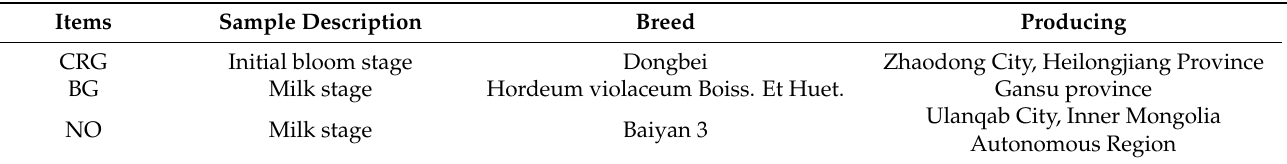
Table 1. Three forages (CRG, BG, and NO) information selected for the current study. Items Sample Description Breed Producing CRG Initial bloom stage